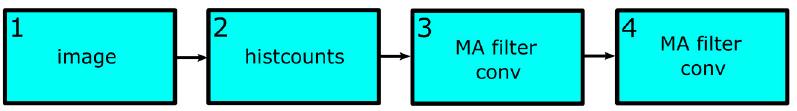
Figure 8. Image histogram generation and filtration.